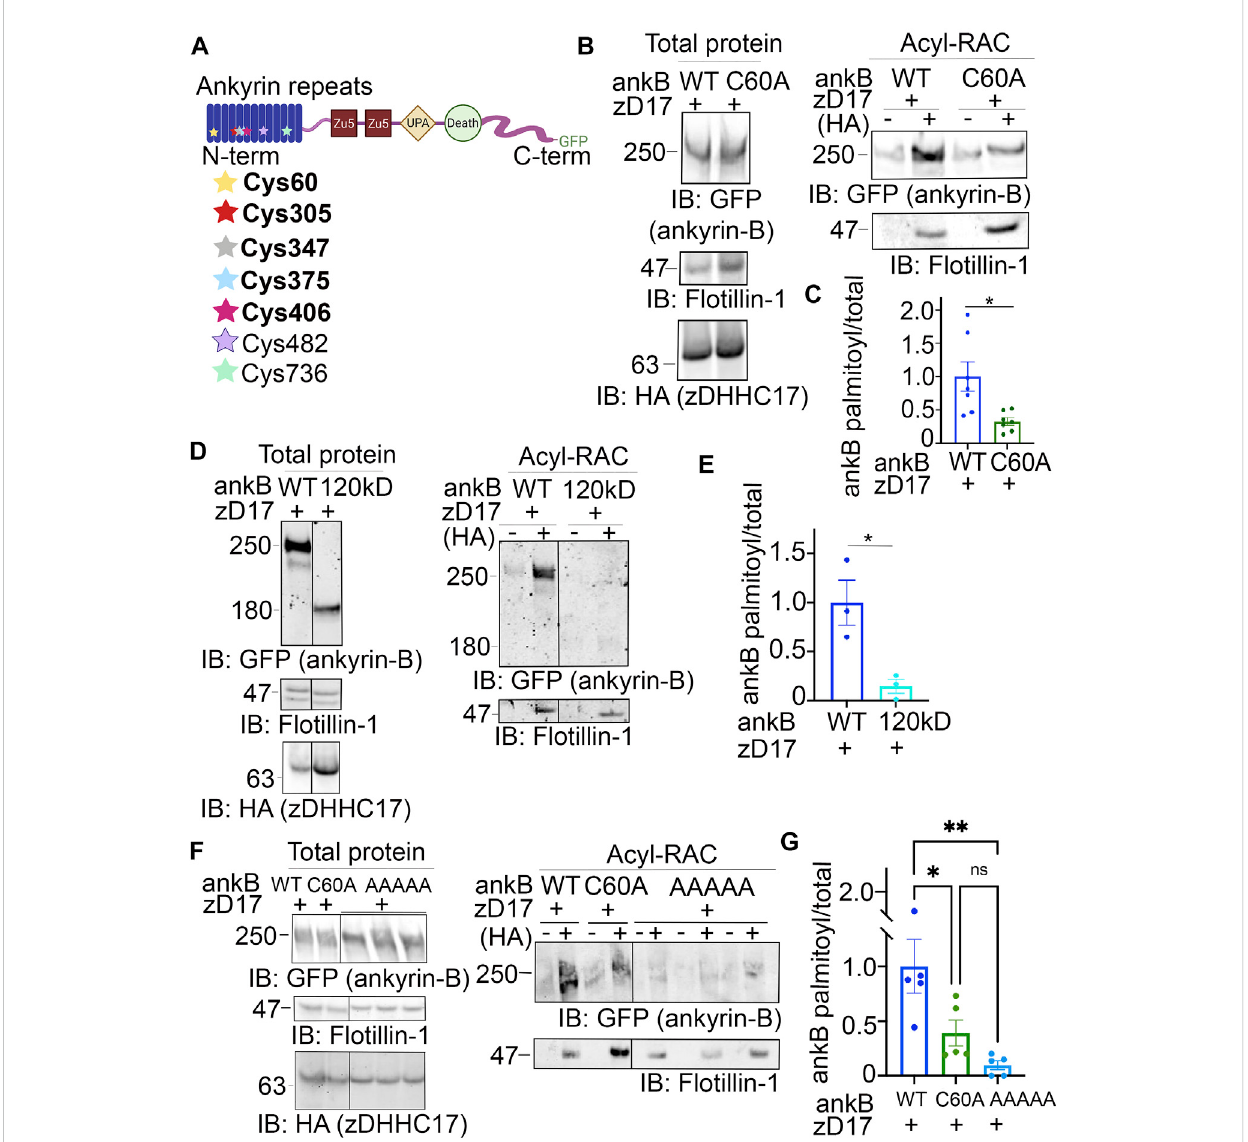
FIGURE 4 Identi fi cation of ankyrin-B S -palmitoylated cysteine sites. (A) . Schematic of the domains in ankyrin-B and the cysteine residues harbored in the N-terminal ankyrin repeat domain, which are candidate palmitoylation sites. Bolded cysteine residues are the cysteine residues that were substituted to alanine to generate the palmitoylation-dead ankyrin-B mutant. (B) . Representative western blot showing total protein levels of ankyrin-B-GFP ( left ) and palmitoylation levels of ankyrin-B-GFP ( right ) from lysates of HEK293T cells transiently co-transfected with WT ankyrin-B-GFP or C60A ankyrin-B- GFP andzDHHC17 processed for theAcyl-RAC assay (N= 7). S -palmitoylation ofC60A ankyrin-B-GFP isgreatly reduced, as evidenced bythelower GFP signal in the ‘ +HA ’ lane compared to that of the WT ankyrin-B-GFP. (C) . Quanti fi ed ankyrin-B-GFP S -palmitoylation levels normalized to total ankyrin-B protein levels for each condition, relative to palmitoylation levels of WT ankyrin-B-GFP co-expressed with zDHHC17. Data from N = 7 independent replicates per condition from (A) . * p = 0.0119; Student ’ s t-test (unpaired). (D) . Representative western blot showing total protein levels of ankyrin-B-GFP ( left ) and palmitoylation levels of ankyrin-B-GFP ( right ) from lysates of HEK293T cells transiently co-transfected with WT ankyrin-B-GFP or 120-kDa ankyrin-B-GFP and zDHHC17 processed for the Acyl-RAC assay (N = 3). All conditions shown are run on the same blot; black line delineates spliced portion ofthegelcontaining acondition notrelevant to this fi gure. S -palmitoylation of120-kDa ankyrin-B-GFP isnot detectedusingan antibodyagainst GFP, as shown by the absence of anti-GFP signal in the ‘ +HA ’ lane, compared to that when WT ankyrin-B-GFP is co-expressed with zDHHC17. (E) . Quanti fi ed ankyrin-B-GFP S -palmitoylation levels normalized to total ankyrin-B protein levels for each condition, relative to palmitoylation levels of WT ankyrin-B-GFPco-expressedwithzDHHC17.Datafrom N=3independentreplicatesperconditionfrom (D) .* p =0.0241; Student ’ s t-test (unpaired). (F) . Representative western blot showing total protein levels of ankyrin-B-GFP ( left ) and palmitoylation levels of ankyrin-B-GFP ( right ) from lysates of HEK293Tcellstransientlyco-transfectedwithWTankyrin-B-GFP,C60Aankyrin-B-GFP,orAAAAA-ankyrin-B-GFPandzDHHC17processedfortheAcyl- RACassay(N=5).Allconditionsshownarerunonthesameblot;blacklinedelineatessplicedportionofthegelcontainingaconditionnotrelevanttothis fi gure. Compared to WT ankyrin-B-GFP and C60A ankyrin-B-GFP, S -palmitoylation of AAAAA-ankyrin-B-GFP is almost completely abolished. (G) . Quanti fi ed ankyrin-B-GFP S -palmitoylation levels normalized to total ankyrin-B protein levels for each condition, relative to palmitoylation levels of WT ankyrin-B-GFPco-expressedwithzDHHC17.Datafrom N=5independentreplicatesperconditionfrom (F) .** p < 0.01,* p < 0.05; one-way ANOVAwith Tukey ’ s post-hoc